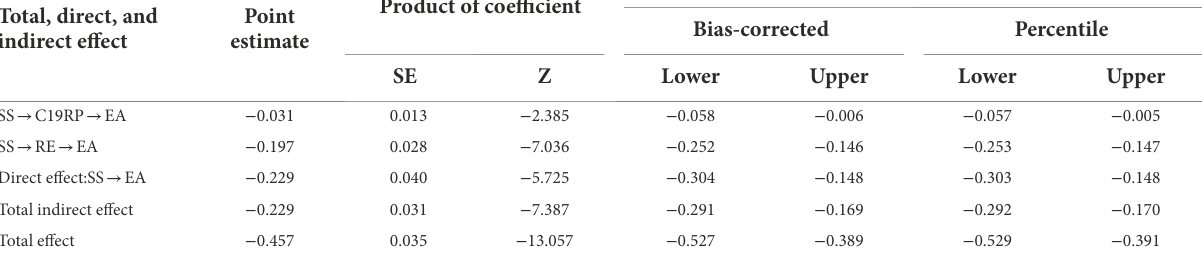
TABLE 2 Mediating effects test.